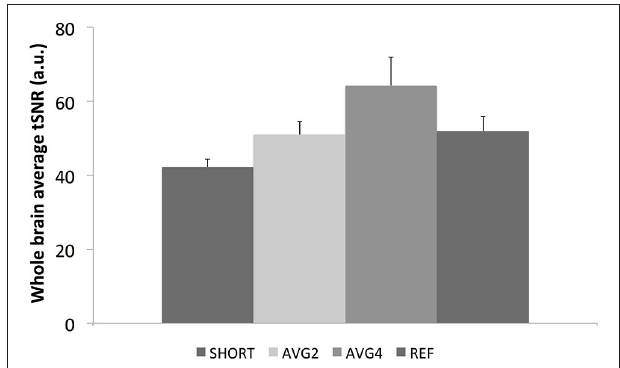
FIGURE 4 | Whole-brain average tSNR values for each EPI sequence. SHORT, TR = 700 ms; AVG2, TR effective = 1400 ms; AVG4, TR effective = 2800 ms; REF, TR = 1440